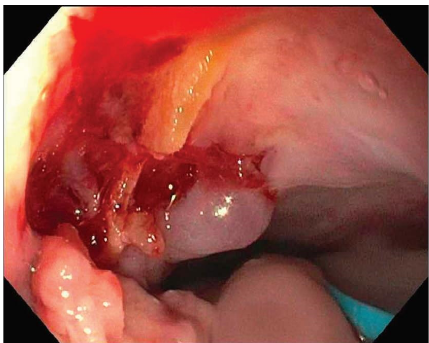
Figure 1: Yellow-tan foreign body in the anterior aspect of the esophagus with surrounding granulation tissue.